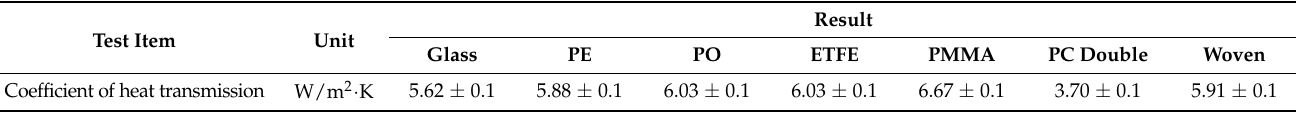
Table 8. Heat performance test results of smart farm covering